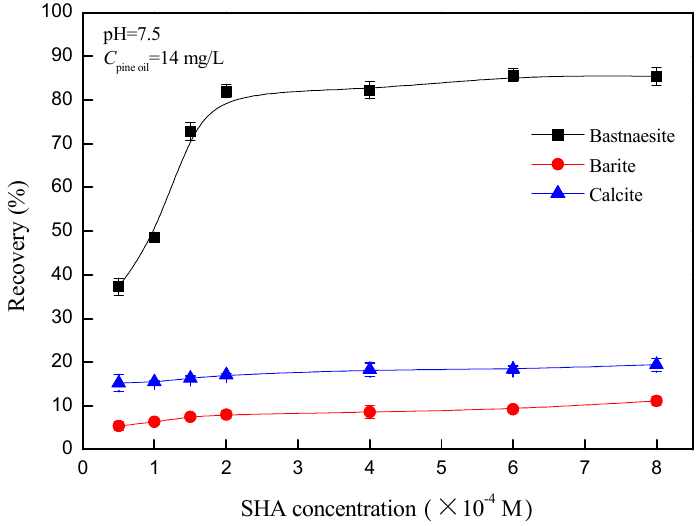
Figure 3. Flotation recoveries as a function of salicylhydroxamic acid (SHA) concentration.